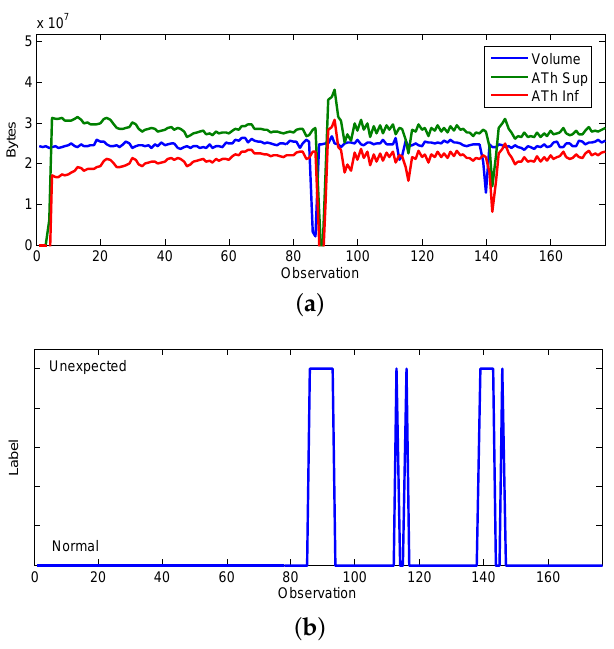
Figure 7. Thresholds and Unexpected traffic on CAIDA’16-sample. ( a ) Traffic volume variation on CAIDA’16-sample; ( b ) Unexpected observations on